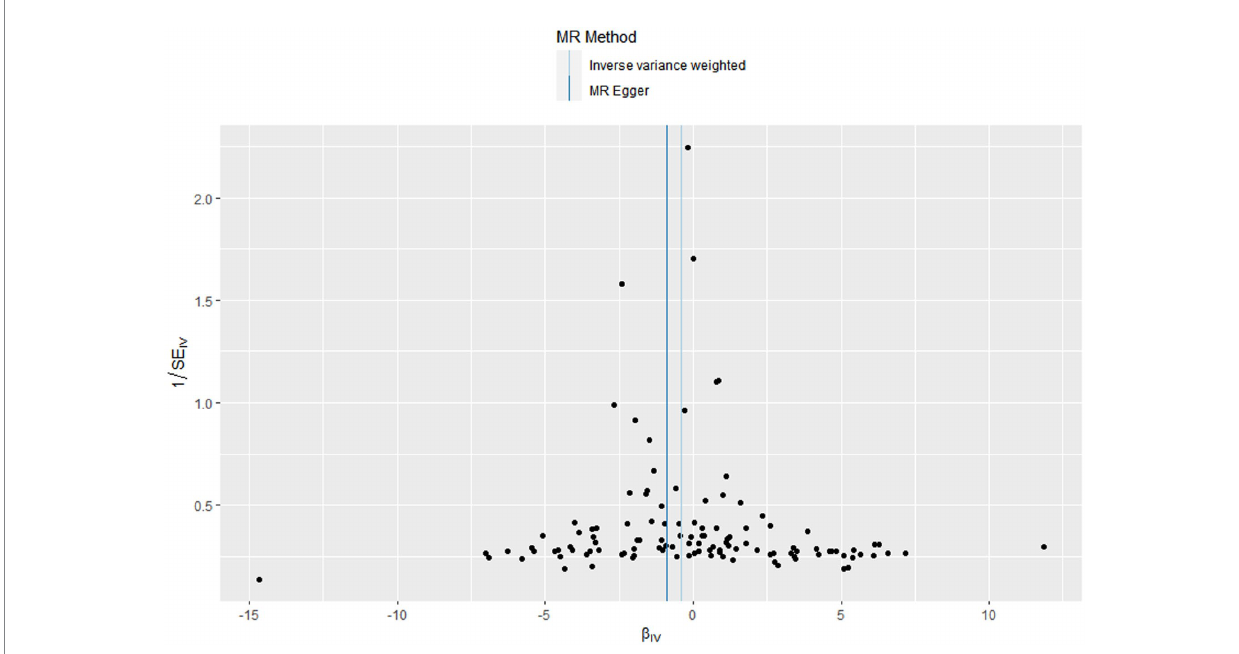
FIGURE 4 Funnel plots to visualize overall heterogeneity of Mendelian randomization (MR) estimates for the effect of Vitamin D on the risk of chronic obstructive pulmonary disease.